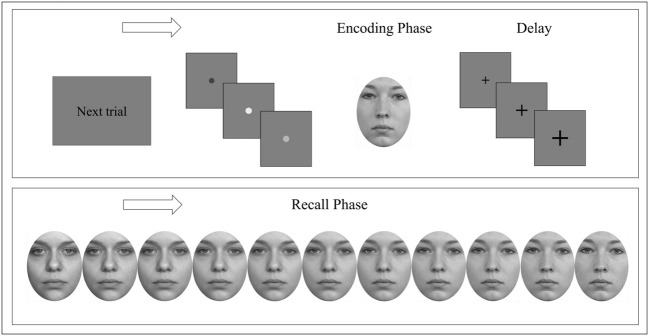
Experimental procedure. A single trial consisted of a go-signal followed by an encoding phase of a target face presented for either 0.8 s or 8 s. Subsequent delay was accompanied by a fixation cross that became enlarged twice. Each recall phase started with a different face either merging into the previously presented target face or a (different) control face. Participants were instructed to respond as soon as they recognized the previously presented target face but to show no reaction in case of target absence. Face stimuli were obtained from Langner et al. (2010).